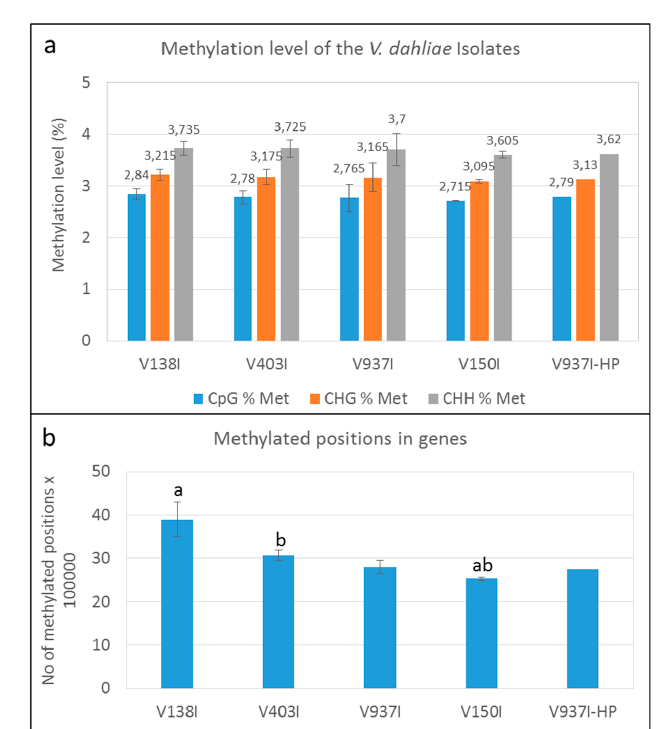
Figure 1. DNA methylation level in the Verticillium dahliae defoliating isolates. ( a ) Methylation level in the genome (%) of the V. dahliae isolates in the CpG, CHG, and CHH sequence contexts. ( b ) Methylated cytosines in the genes of the four non parented V. dahliae isolates. “a” or “b” above the bars indicate that those data significantly differed ( p < 0.05). Only one datum of the V937I-HP biological replicate sequenced by bisulfite treatment is represented.